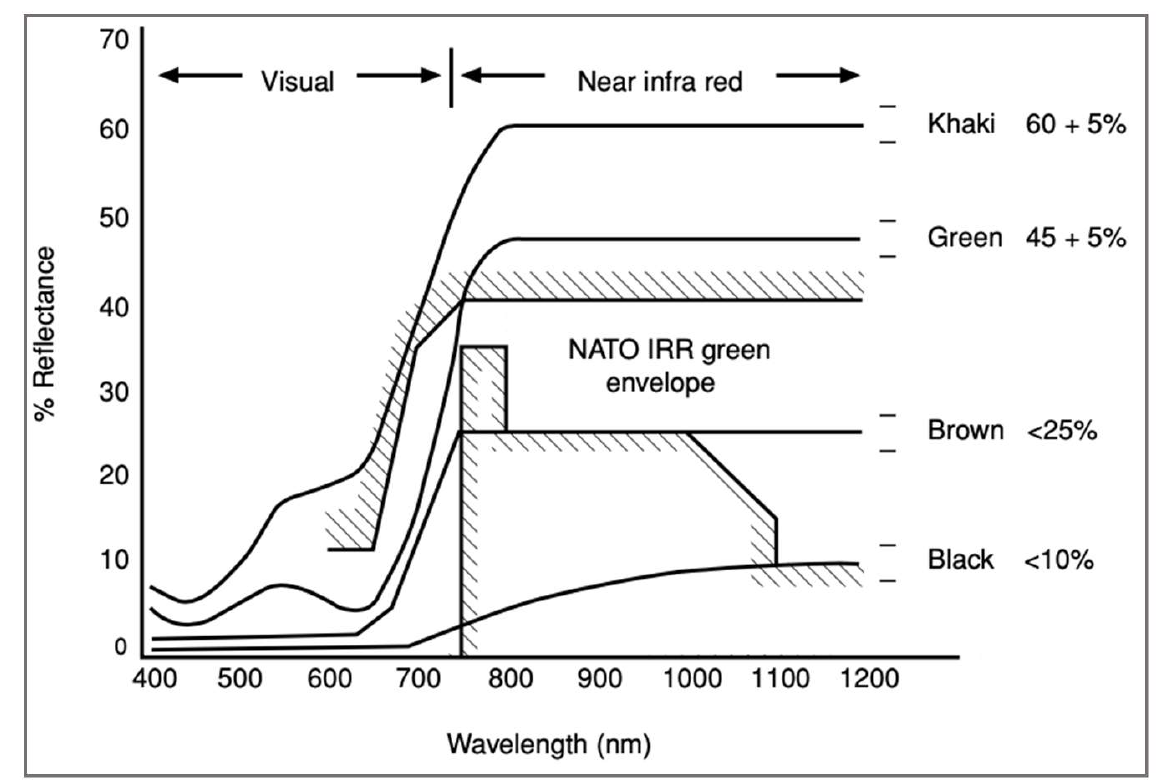
Figure 1. Spectral reflectance curves of four colors commonly used for military camouflage textiles in the visual and near infrared wavelengths. The North Atlantic Treaty Organization (NATO) near-infrared green envelope has been superimposed over the reflectance curves (reproduced from [2] with permission from Elsevier).